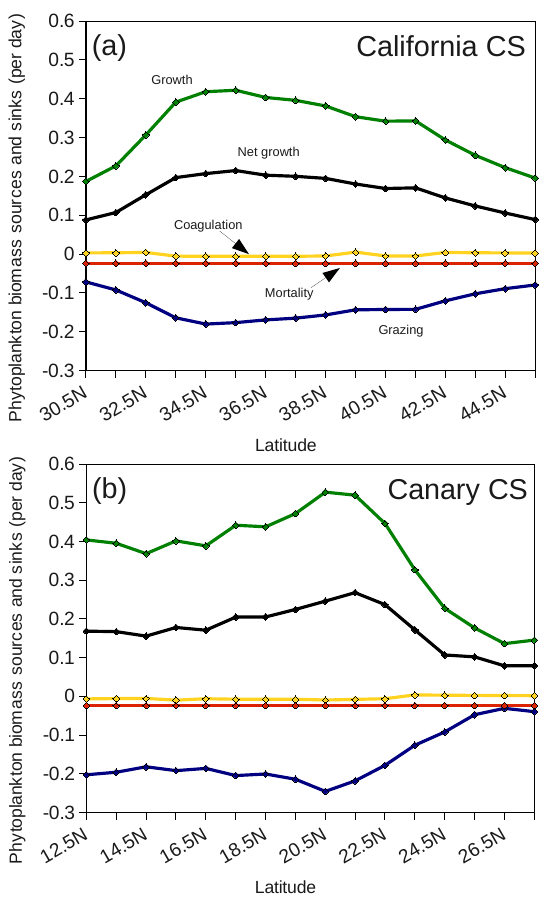
Fig. 8. Meridional distribution of the net growth of phytoplankton (black) and its four components: the growth (green), the grazing (blue), the mortality (red) and the coagulation (yellow) daily rates in the California CS (a) and the Canary CS (b) . Data is horizontally averaged over the 300km wide nearshore area and vertically over the upper 40m.